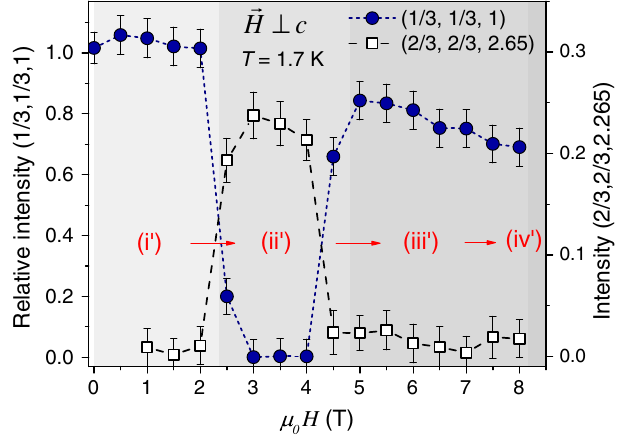
FIG. 16. Field dependence of ( 1 , 1 , 1) and ( 2 , 2 , 2.654) magnetic 3 3 3 3 peak intensities at T ¼ 1 . 7 K mapping out the phase diagram for ⃗ H k½ 1 ; ¯1 ; 0 (cid:2) . One observes that the intermediate incommensurate phase separating two other field-induced commensurate states begins at about 2 T and disappears near 4.5. The dashed line is a guide to the eye.